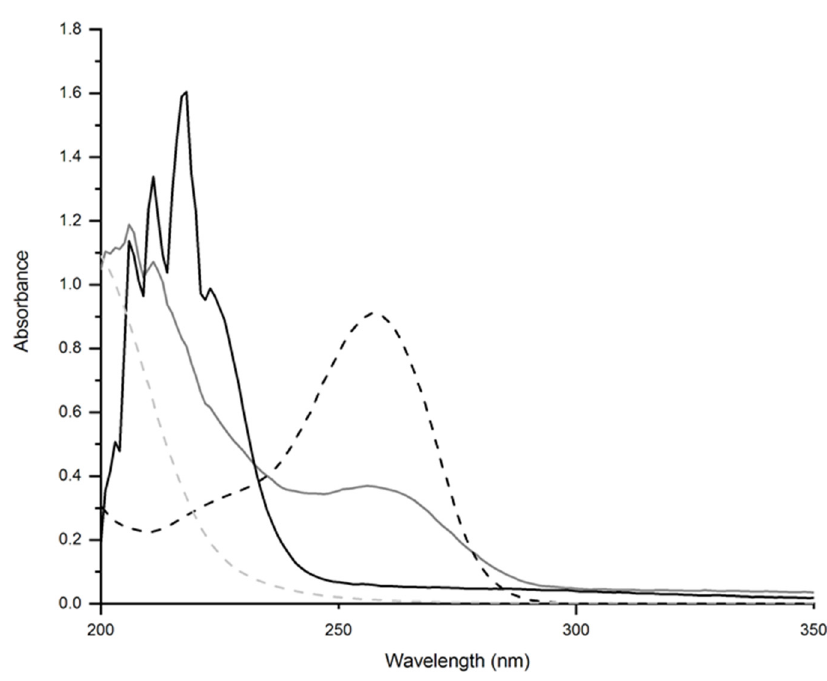
Figure 1. UV-Vis spectra of CS (solid black line), modified CS (grey line), pyrrole carboxylic acid (black dashed) and methacrylic acid (grey dashed).